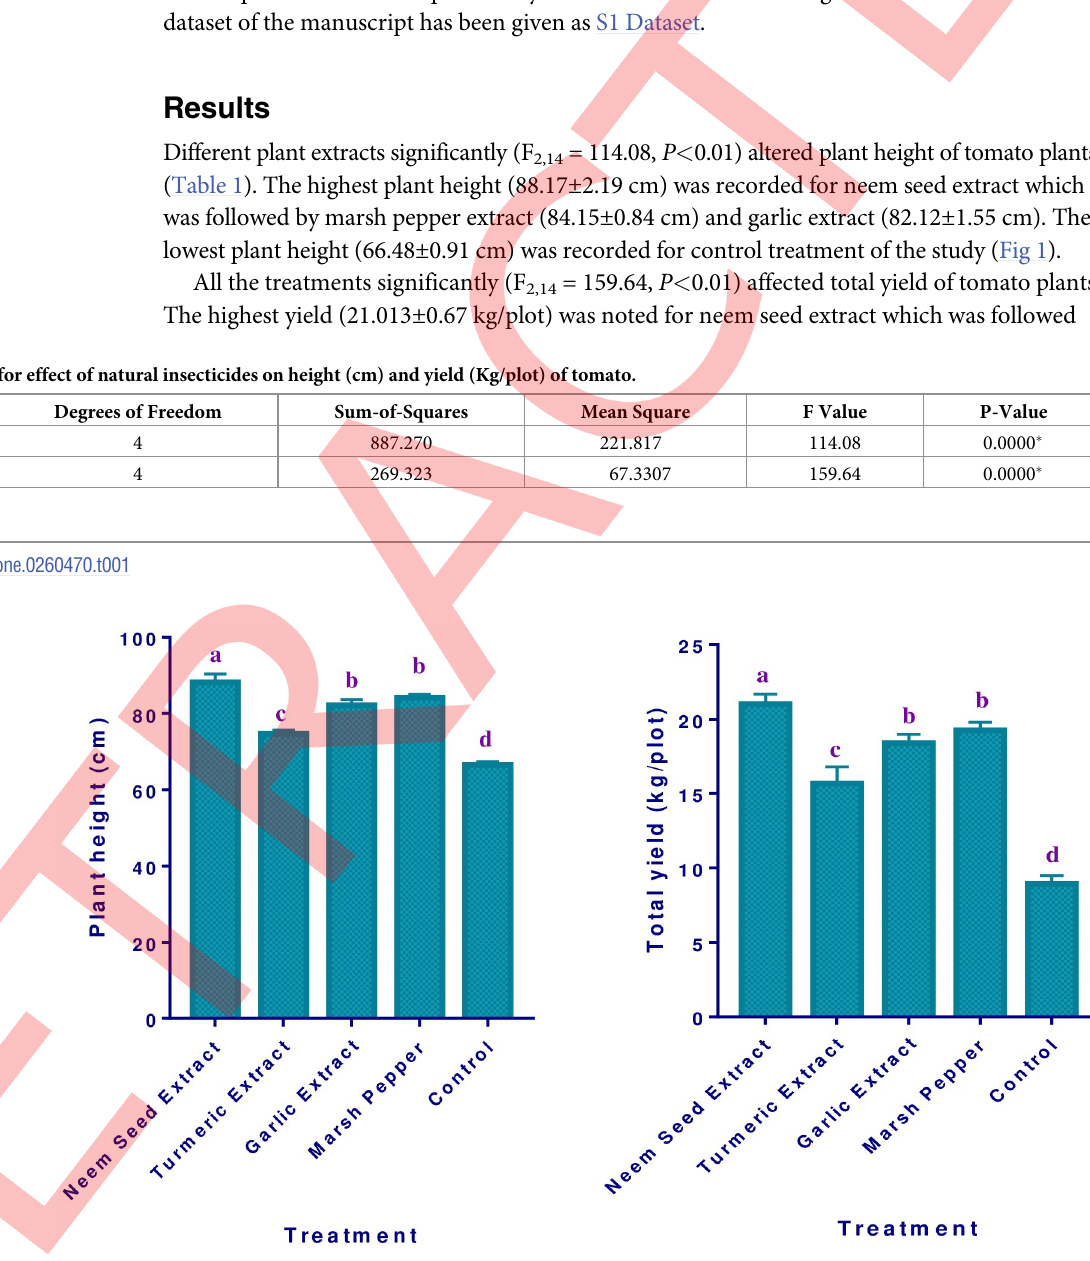
Fig 1. The impact of different plant extracts on plant height (cm) and yield (kg/plot) of tomato plants. The values are means ± SD (n = 3). Different lower-case letters on bars indicate significant differences among treatments at P < 0.05.